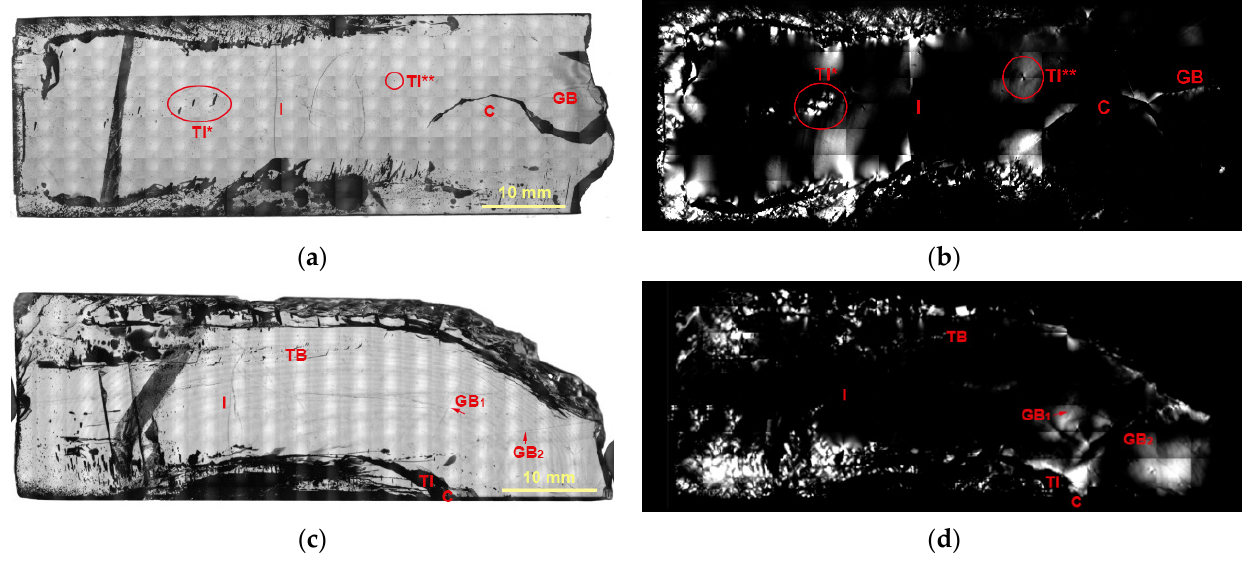
Figure 5. Infrared transmission images and birefringence images of F1-02 ( a ) and ( b ) and F1-03 ( c ) and ( d ). Abundant large sized inclusions in the peripheral regions of both slabs generate high degree of stress filed. An evident reduction of stress generated at the interface (I) of F1-03 was observed when compared to F1-02. Most of the stress originates from twin boundary (TB), inclusions (TI), grain boundaries (GB) and cracks (C).